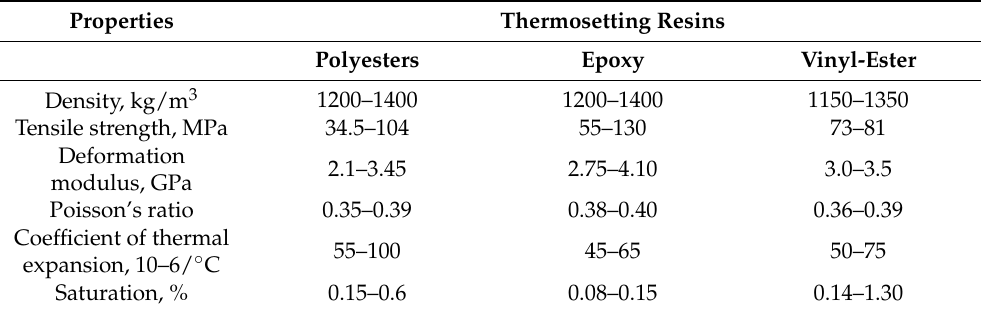
Table 2. Typical matrix of FRP materials